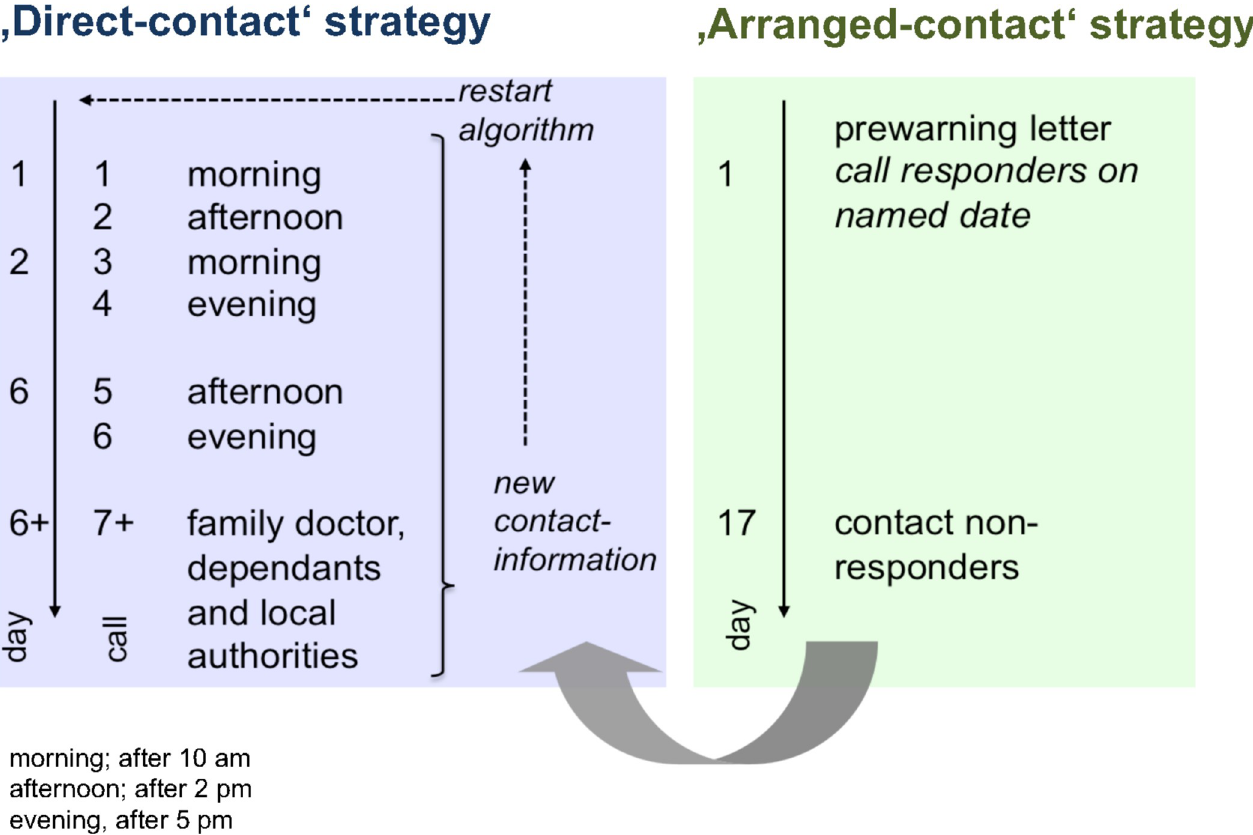
Fig 1. A scheme of the applied contract strategies. Fig 1 outlines the predefined contact schedule for the ‘direct contact’ (contact strategy 1) and the ‘arranged contact’ (contact strategy 2)